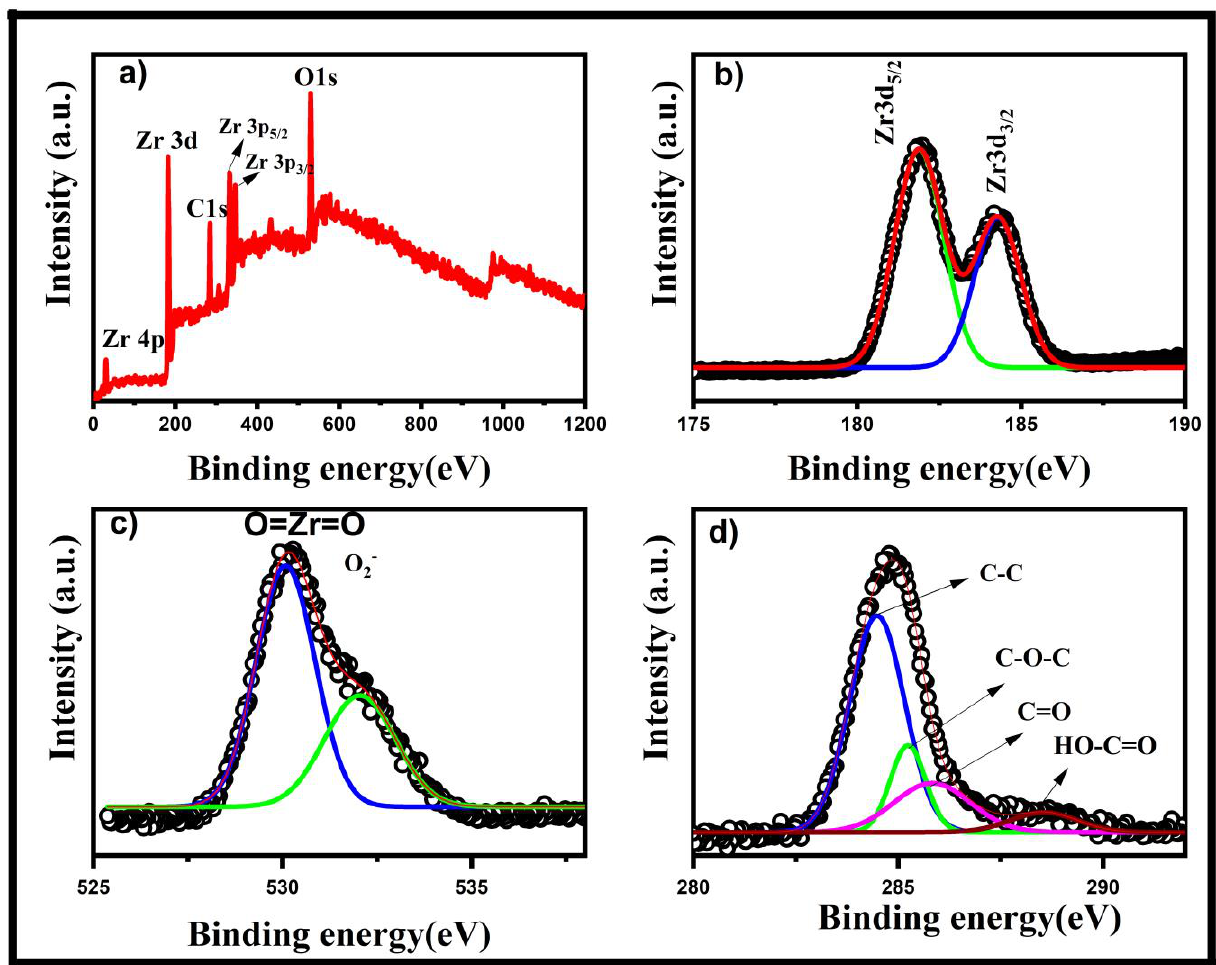
Figure 6. XPS wide ( a ), Zr-2p ( b ), O-1s ( c ), and C-1s ( d ) spectra of biosynthesized ZrO 2